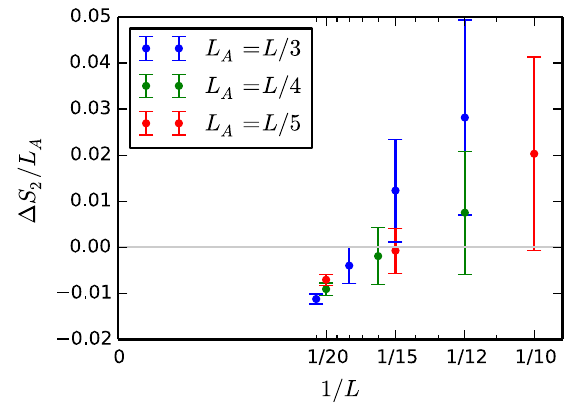
FIG. 7. Scaling of the Renyi entropy deviation Δ S 2 with 1 =L , =L , averaged over all eigenstates in the range for constant ratio L A 0 . 28 < β < 0 . 32 . As in Fig. 5, the error bars represent one standard deviation away from the